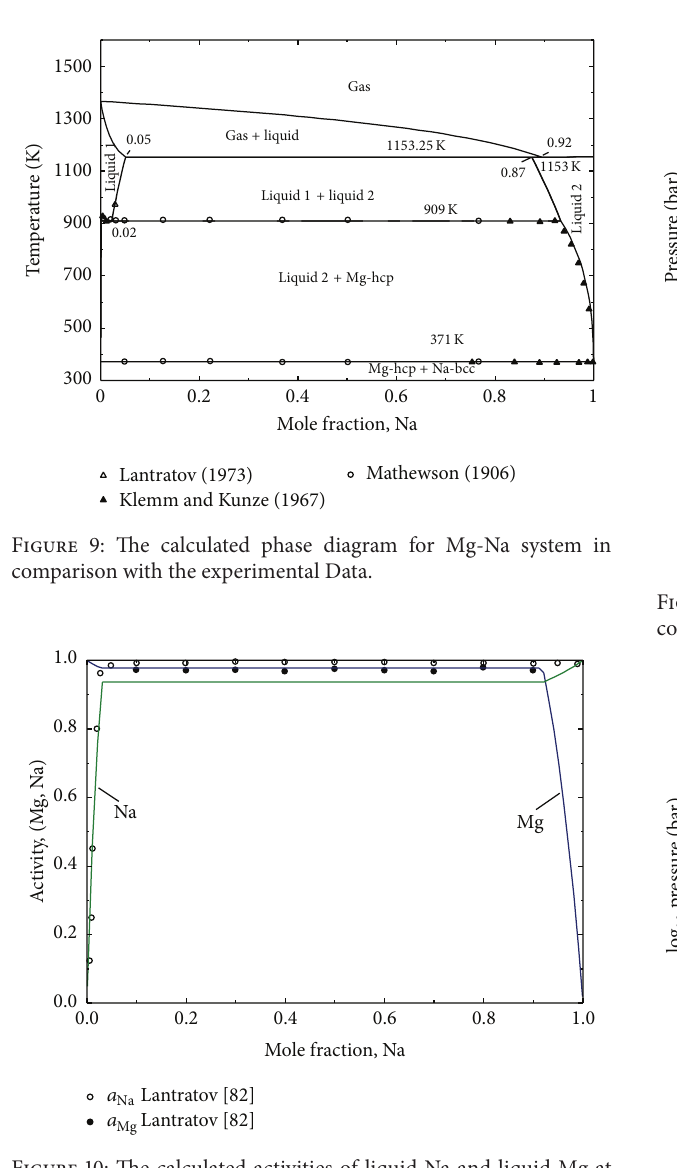
Figure 10: The calculated activities of liquid Na and liquid Mg at 973 K in comparison with the experimental data [82]. pressures for NaMgH 3 are shown as the shaded region in Figure 12 as this region avoids the liquid formation.